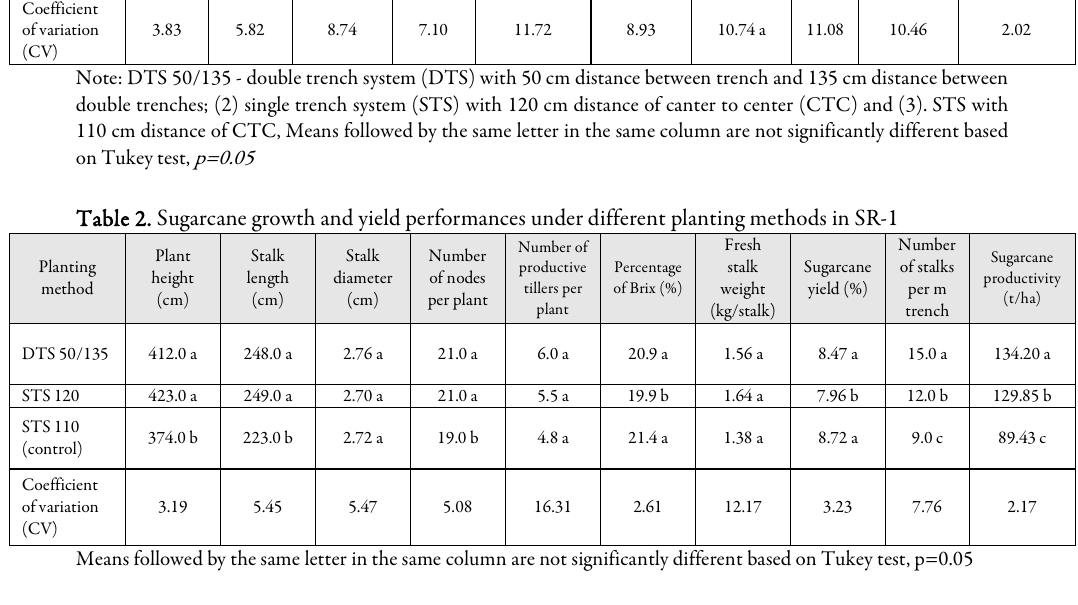
Table 3. Sugarcane growth and yield performances under different planting methods in SR-2 Planting